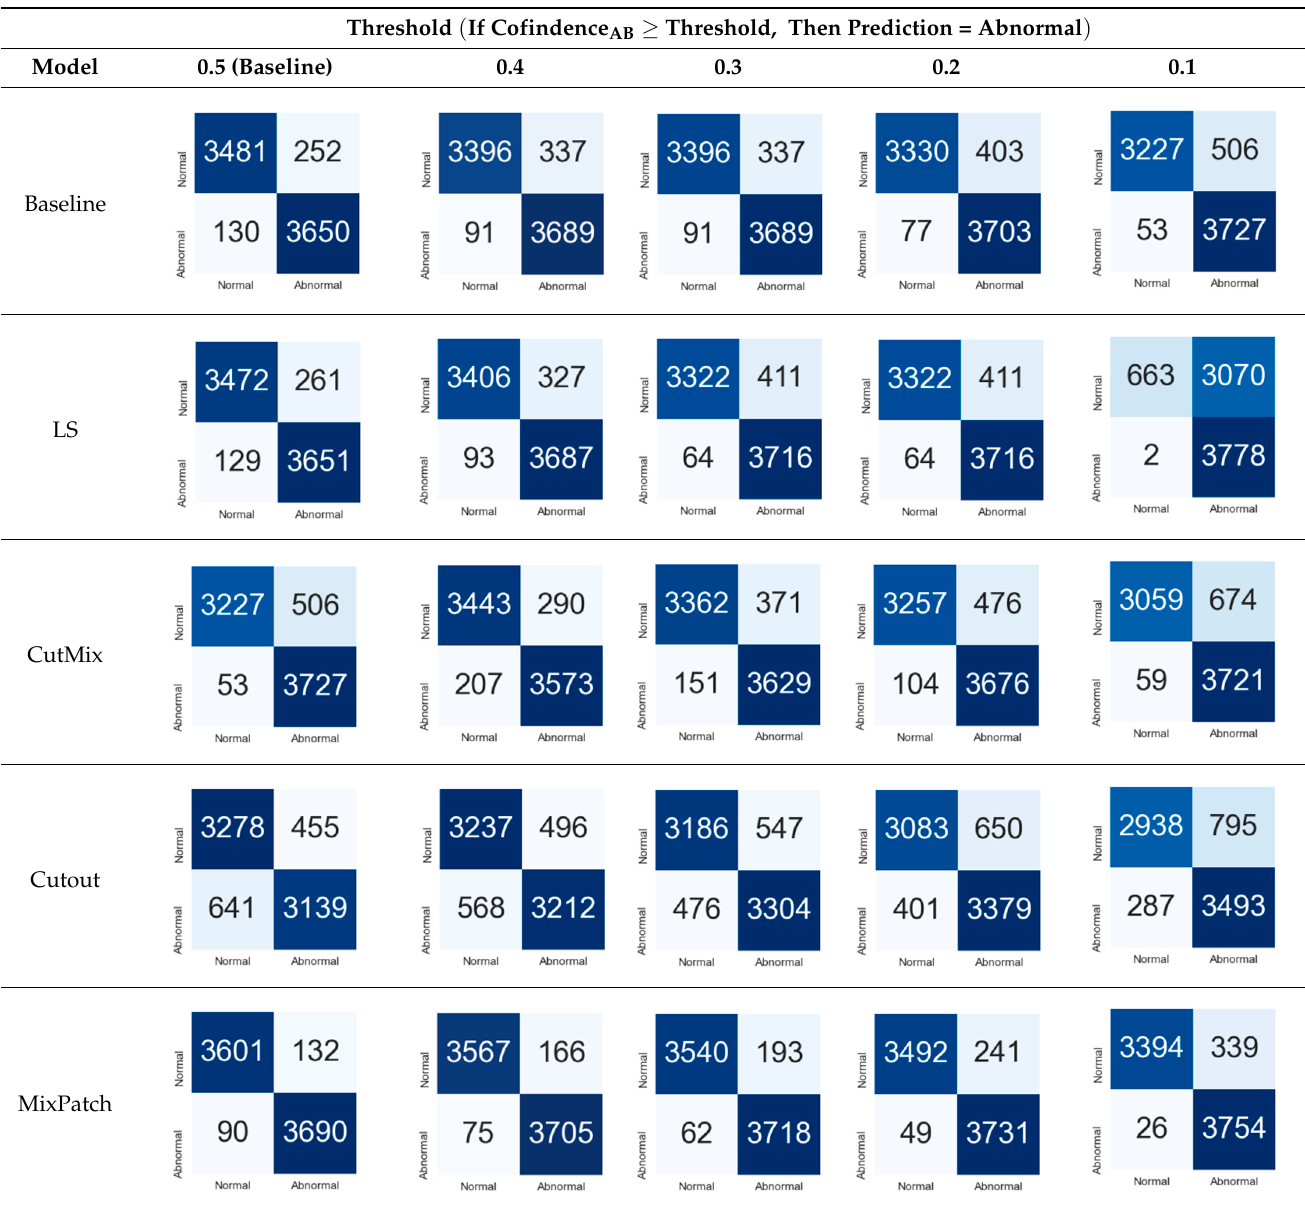
3 of 3 Table 7. Confusion matrix for each method with a threshold approach (X = prediction, Y =